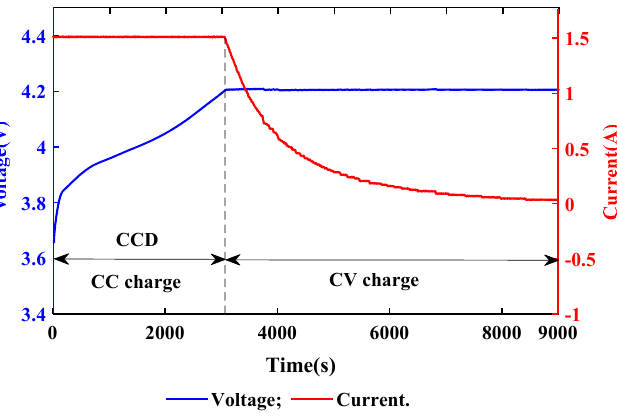
Figure 2. The charge voltage and current curves at cycle 40.